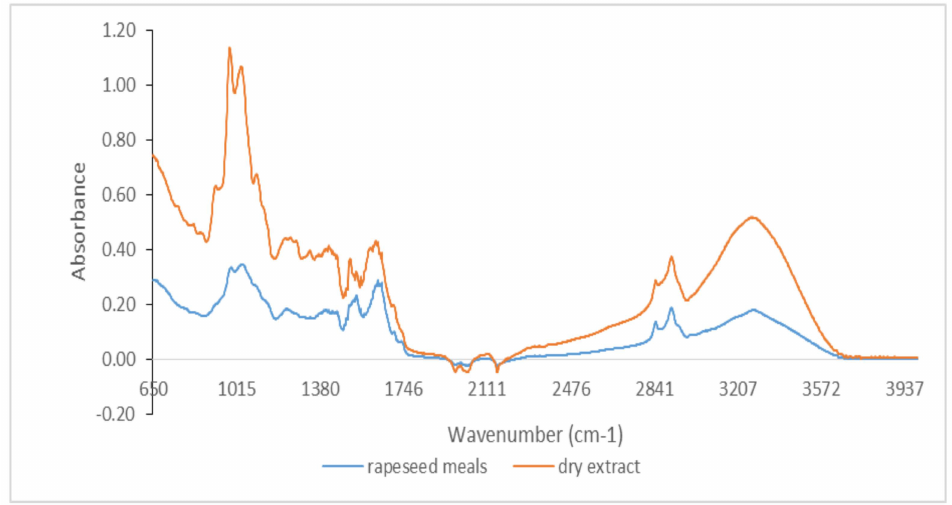
Figure 3. FTIR spectra for rapeseed meals and its dry extract in the region between 650 and 4000 cm − 1 .